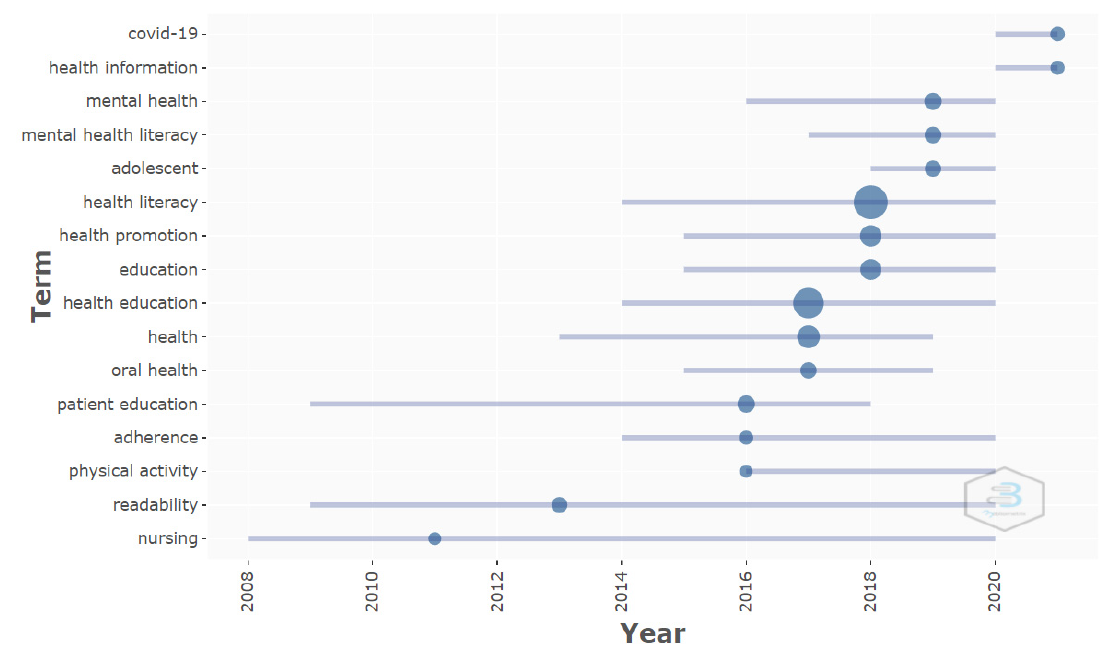
Figure 9. Trend topics authors’ KeyWords Plus.